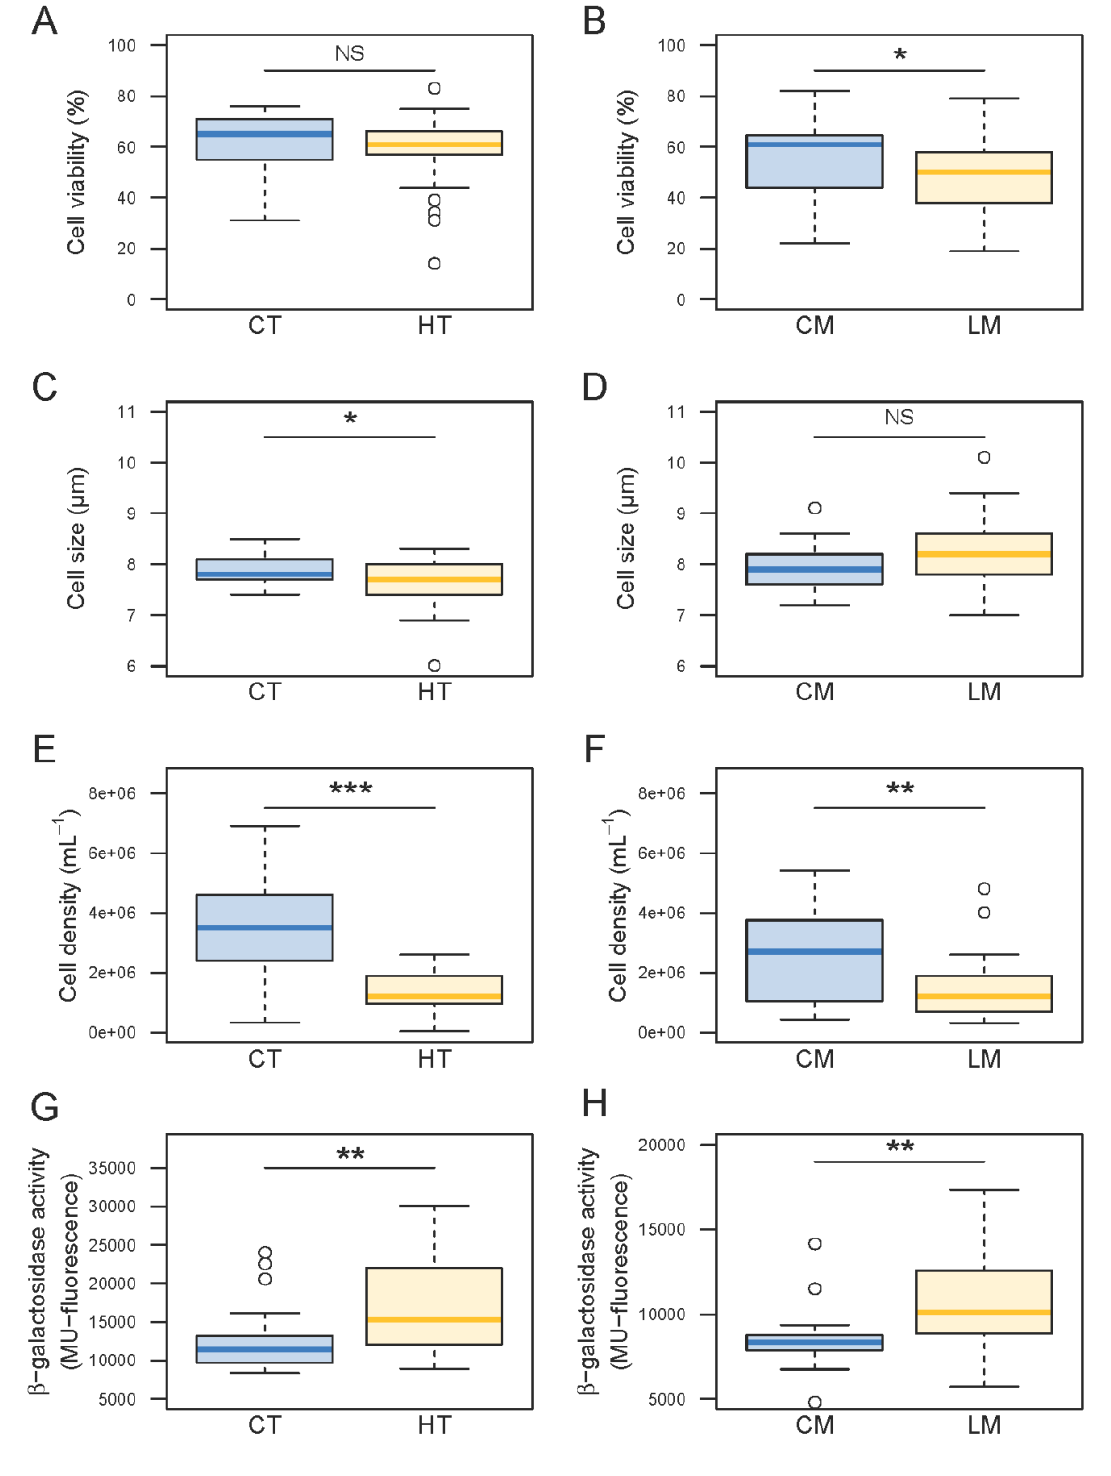
Figure 2 - Effect of the two environmental stressors (Temperature (A, C, E, and G) and Moisture (B, D, F and H) on Immune cell viability (A and B), Immune cell size (C and D), Immune cell density (E and F) and β -galactosidase activity (G and H)). Blue colour: control groups, orange colour: stress groups. CT: Control Temperature (20°C), HT: High Temperature (28°C), CM: Control Moisture (80%), LM: Loss of Moisture (50%). NS: No significant; * P<0.05, ** P<0.01, ***